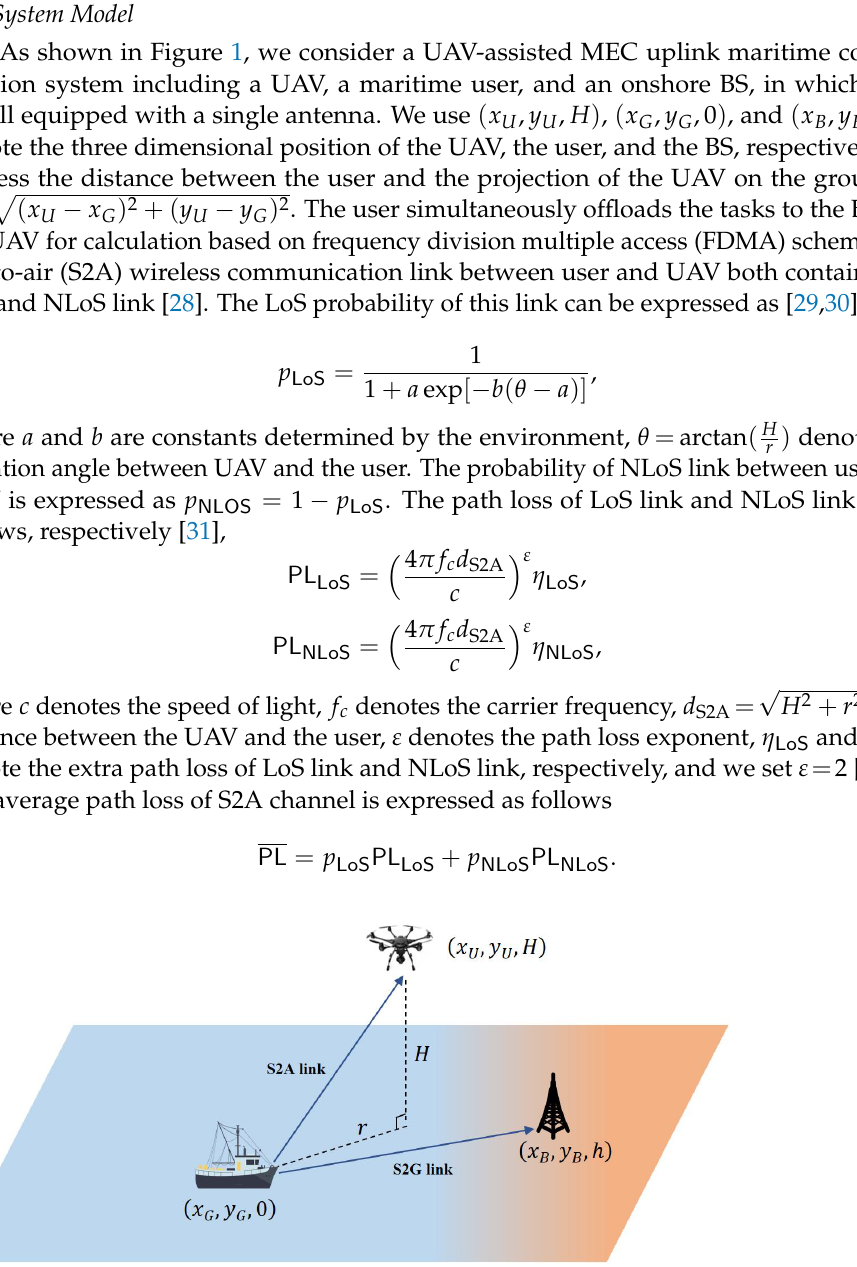
Figure 1. A UAV-assisted MEC uplink communication